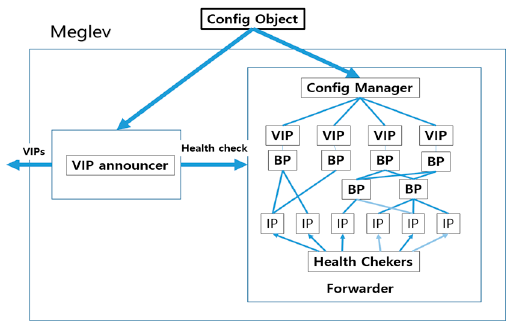
Figure 2. The Configuration of Maglev with Load Balancing.